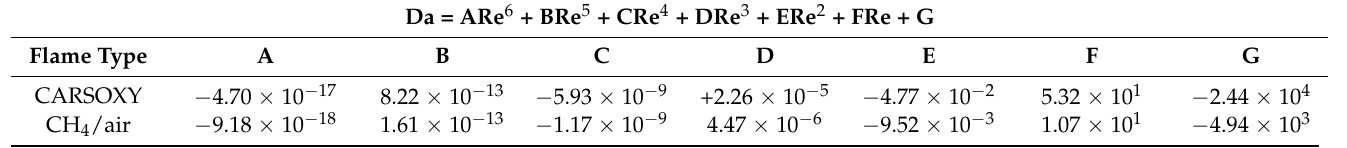
Table 5. Da correlations as functions of Re.